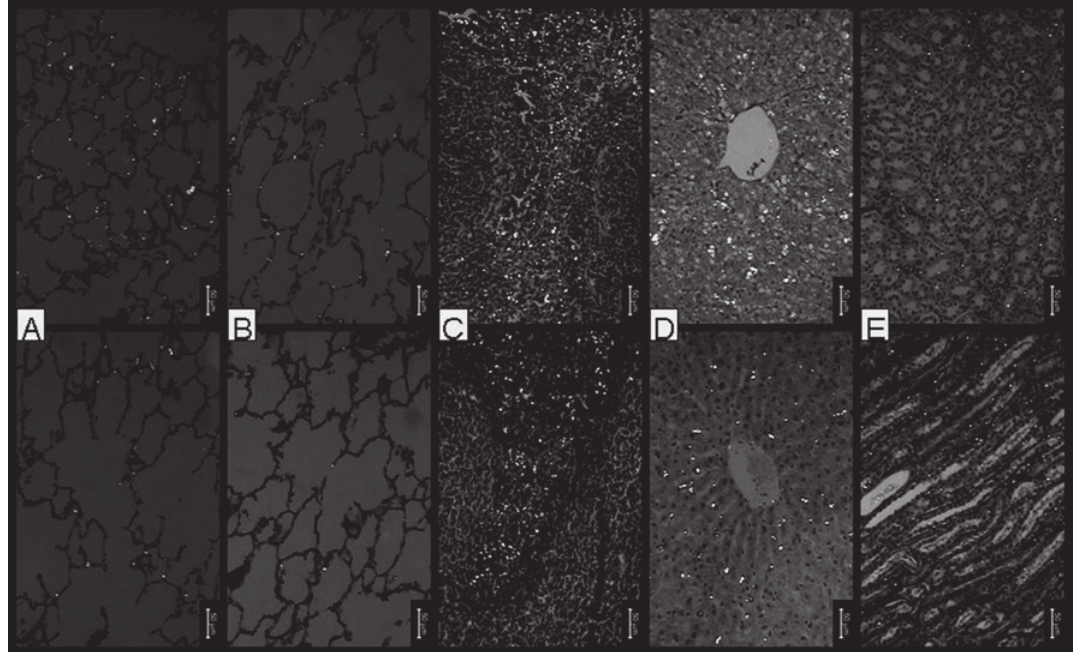
Figure 3 - Photomicrographs of the left (A) and right lung (B), spleen (C), liver (D), and kidney (E) of rabbits submitted to th intrapleural instillation of small-particle talc (< 5 µm) (upper panel) and mixed talc (90% of particles > 10 µm) (lower panel) obtained after 24 hours (hematoxylin and eosin, polarized light, magnification: x200). Note the scattered birefringent talc particles observed in both